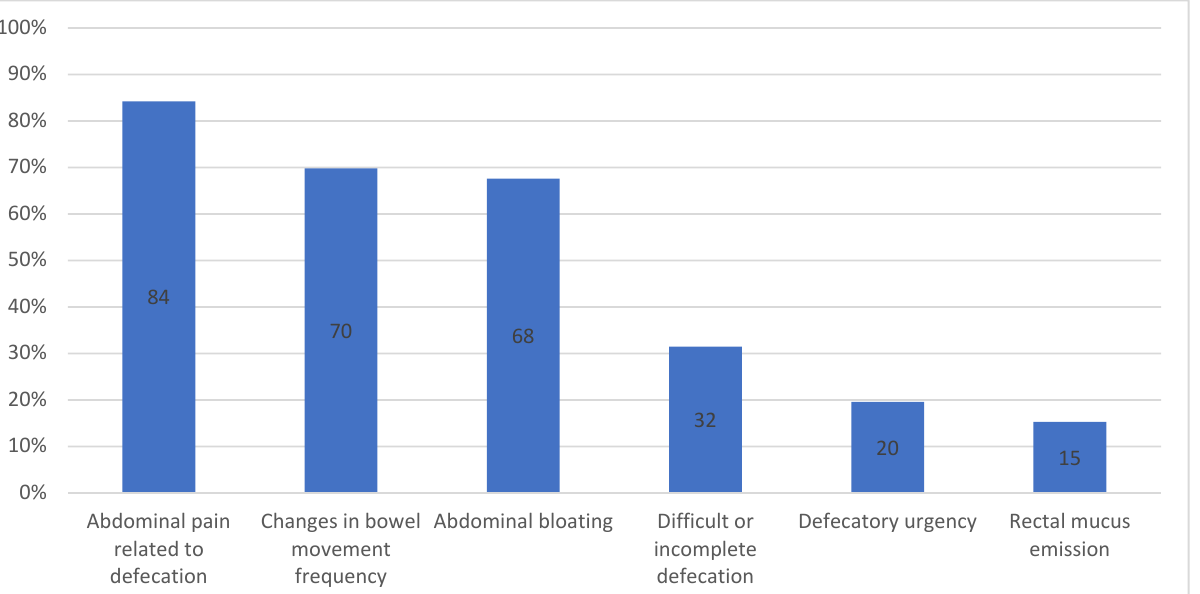
Table 5. IBS pathophysiology: frequency of “likely” responses.